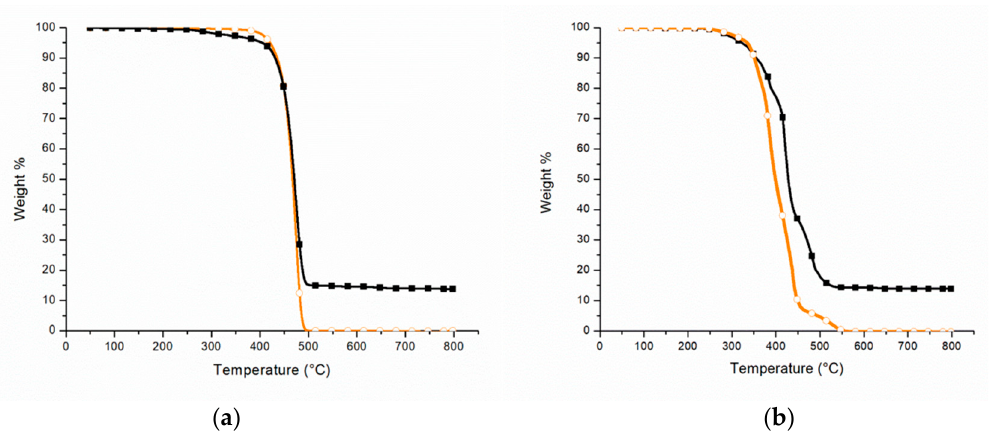
Figure 1. TGA in ( a ) nitrogen and ( b ) air of PEAL (black square) and LDPE (orange circle).